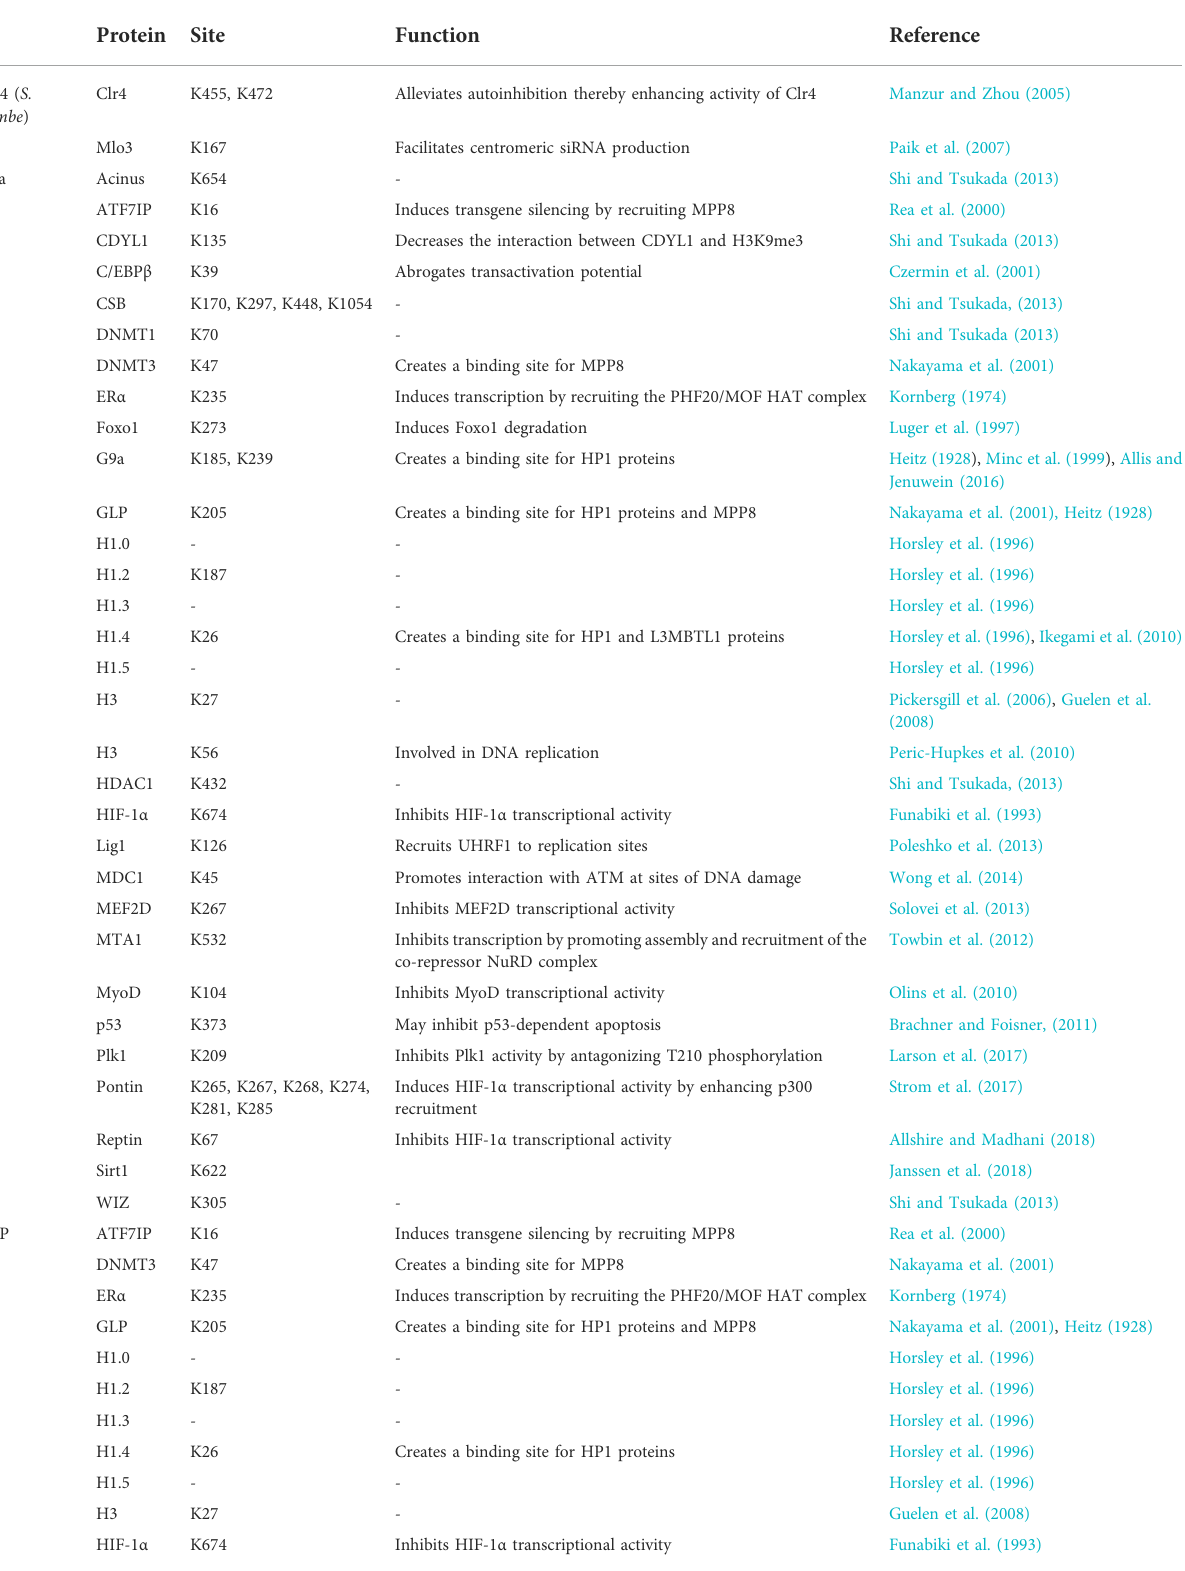
TABLE 1 Summary of additional histone and non-histone targets of H3K9